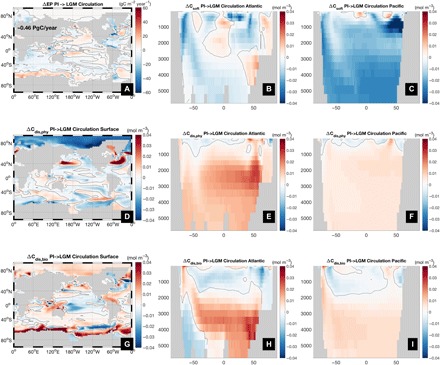
Effect of circulation changes on carbon storage.Change in (A) EP, (B and C) Csoft, (D to F) Cdis,phy, and (G to I) Cdis,bio due to changes in circulation. Black solid line is the zero contour.